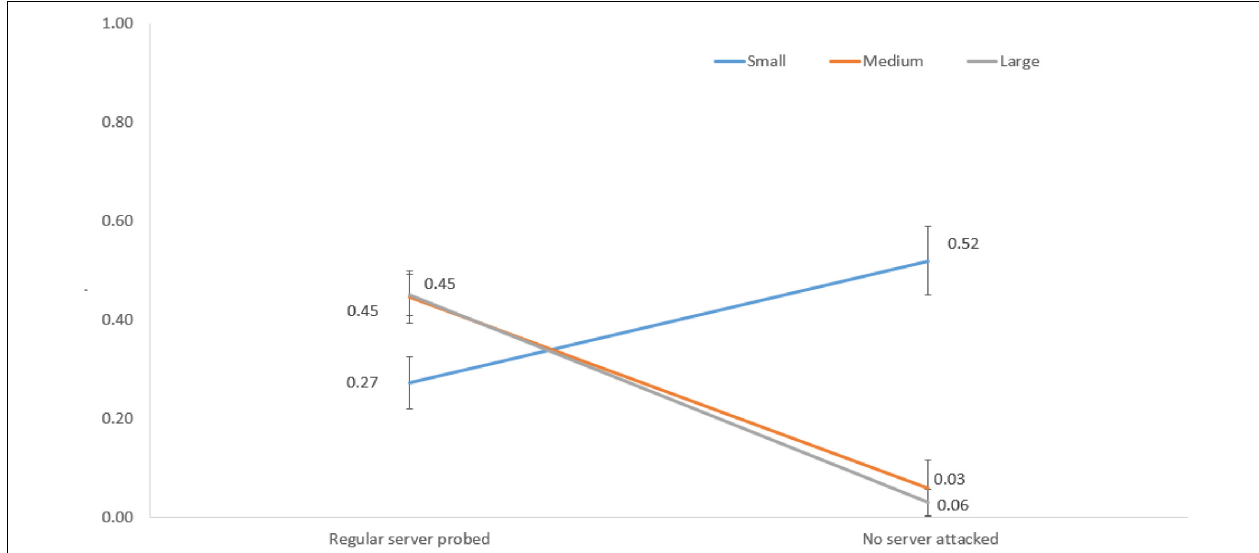
FIGURE 9 | The proportions of regular server probed and no server attacked decisions in different network sizes.